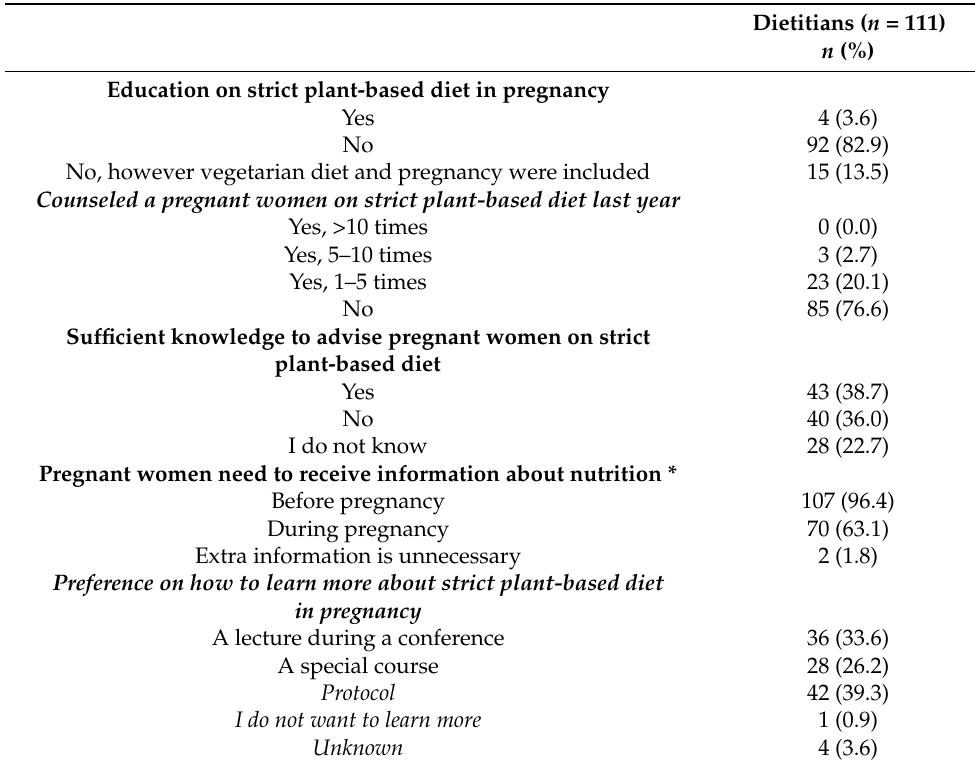
Table 4. Report of